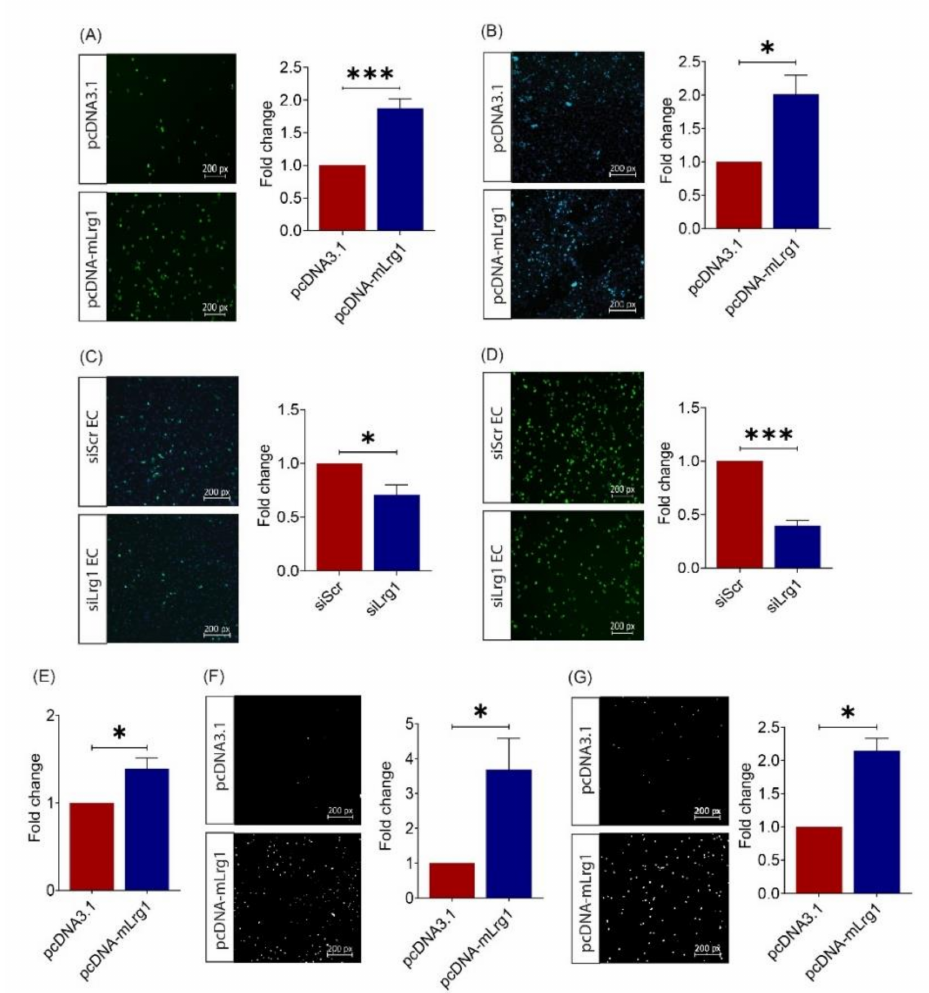
Figure 4. Lrg1 promotes B16F10 cell invasiveness in vitro. ( A ) Representative images and quantitative analysis of the number of CMFDA-positive Lrg1 overexpressing or control B16F10 cells adhered to the HPMEC monolayer. ( B ) Representative images and quantitative analysis of the number of CMFDA-positive Lrg1 overexpressing B16F10 cells that migrated through the HPMEC monolayer. ( C ) Representative images and quantitative analysis of the number of CMFDA-positive B16F10 cells adhered to the HPMECs subjected to siRNA-mediated LRG1 knockdown. ( D ) Representative images and quantitative analysis of the number of CMFDA-positive B16F10 cells that migrated through the HPMECs subjected to siRNA-mediated LRG1 knockdown. ( E ) Quantitative analysis of Lrg1 overexpressing or control B16F10 cells adhered to fibronectin. ( F ) Representative images and quantitative analysis of invaded Lrg1 overexpressing and control B16F10 cells using the Matrigel invasion assay. ( G ) Representative images and quantitative analysis of migrated Lrg1 overexpressing or control B16F10 cells in Transwell. Migrated and invaded cells are labelled by DAPI. All images are representative. Data are presented as mean ± SEM. of three independent experiments. Statistical analyses were performed via two-tailed, unpaired Student’s t-test. * p < 0.05; *** p <